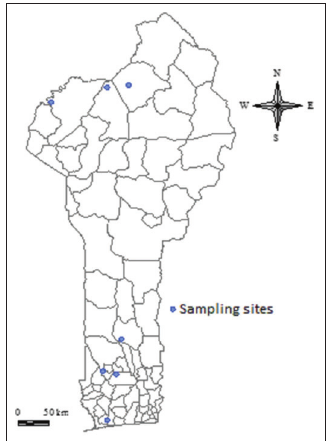
Figure-1: Sampling